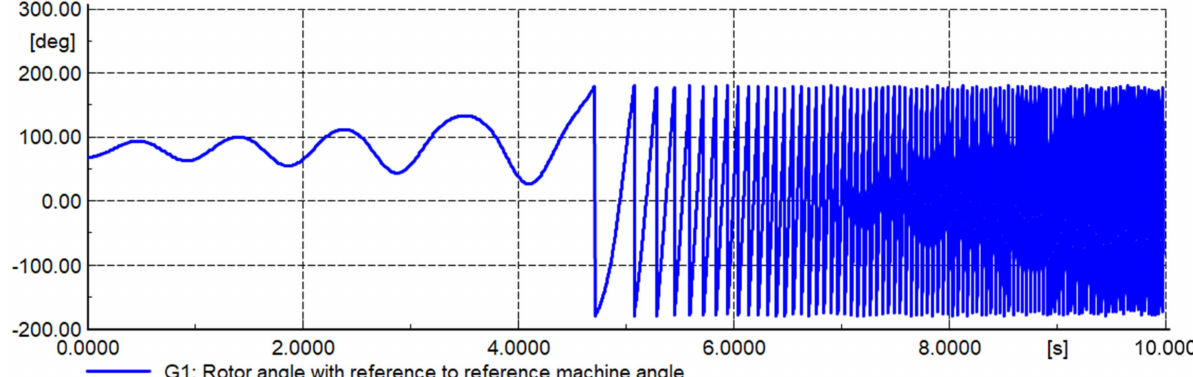
Figure 14. Test 1 : Rotor angle of G1 generator behaviour without OOS protection on CCT-1